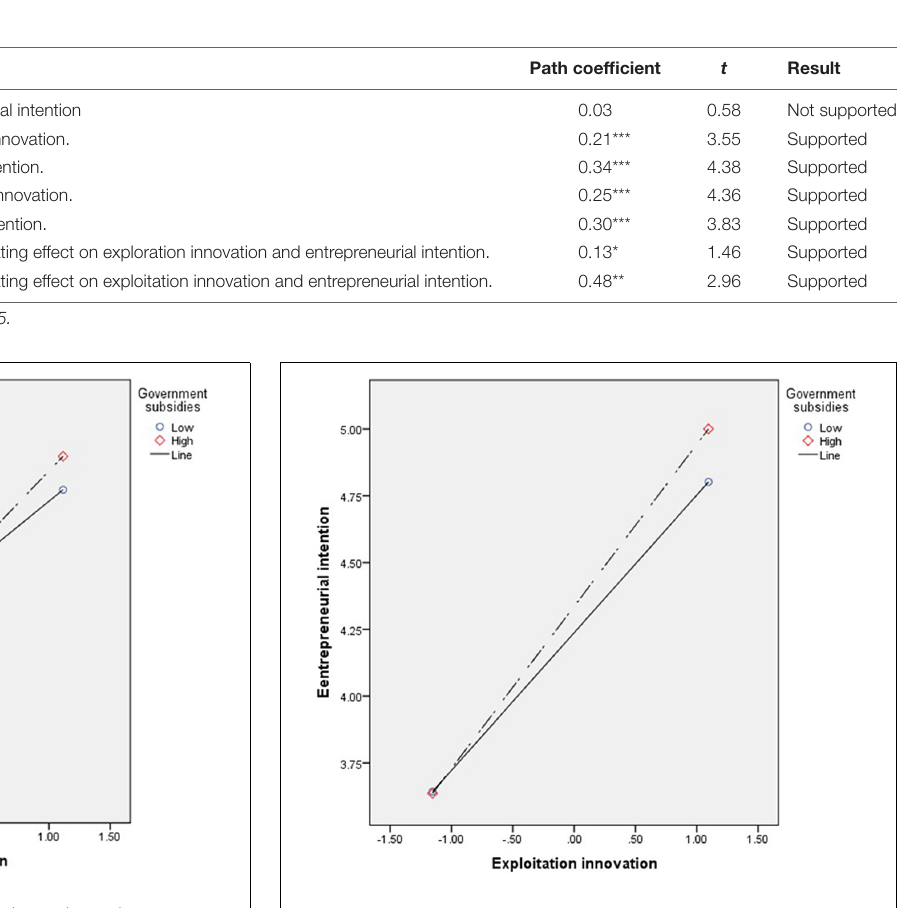
FIGURE 3 | The interaction effect of exploitation innovation and government subsidies on entrepreneurial